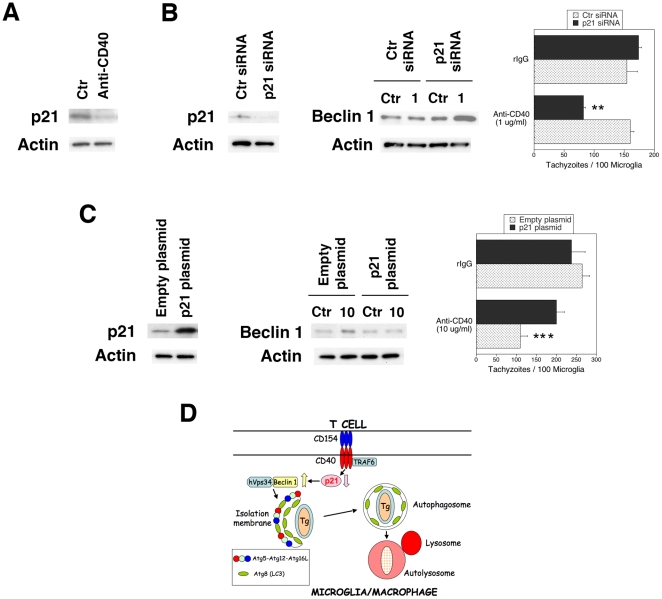
CD40 downregulates p21, increases Beclin 1 expression and autophagic killing of T. gondii.
A, Primary brain microglia from B6 mice were incubated with anti-CD40 mAb or control mAb for 1 h followed by assessment of p21 and actin expression. B, BV-2 cells were transfected with control or p21 siRNA. Cells were incubated with a suboptimal concentration of anti-CD40 (1 µg/ml) or control mAb and followed by assessment of Beclin 1 expression. In addition, cells were challenged with RH T. gondii and the numbers of tachyzoites per 100 microglia were determined. C, BV-2 cells were transfected with p21-encoding or empty plasmids. Cells were incubated with an optimal concentration of anti-CD40 (10 µg/ml) or control mAb and followed by assessment of Beclin 1 expression. Cells were challenged with RH T. gondii and the numbers of tachyzoites per 100 microglia were determined. Results are shown as the mean ± SEM and are representative of 3 independent experiments. D, Proposed model of the role of p21 in modulation of Beclin 1 expression and activation of T. gondii killing induced by CD40. We previously reported that CD40 induces autophagy and killing of T. gondii through the adaptor protein TRAF6 [6], [8]. This process would be dependent on down-regulation of p21 that would result in increased levels of Beclin 1 and enhanced autophagy. **p≤0.01; ***p≤0.001.